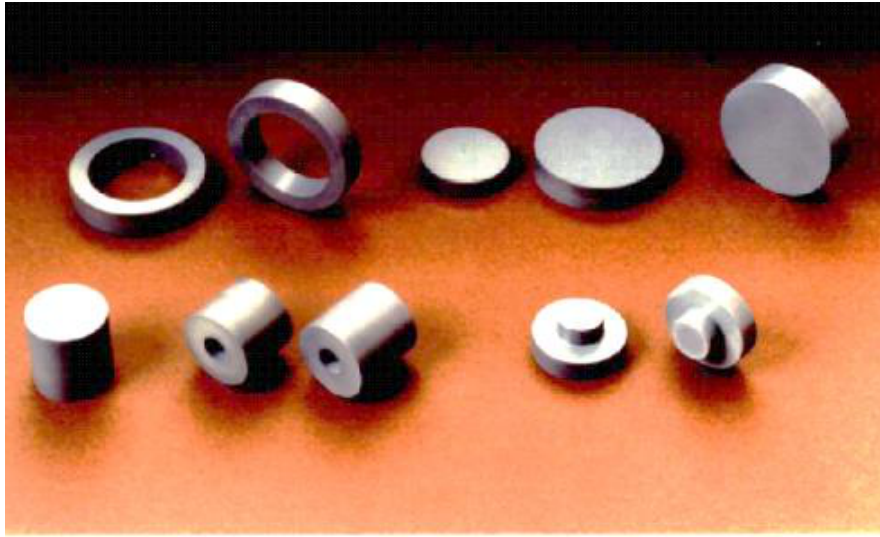
Figure 36. Si 3 N 4 /Al 2 O 3 composite parts for Homogenizing device.